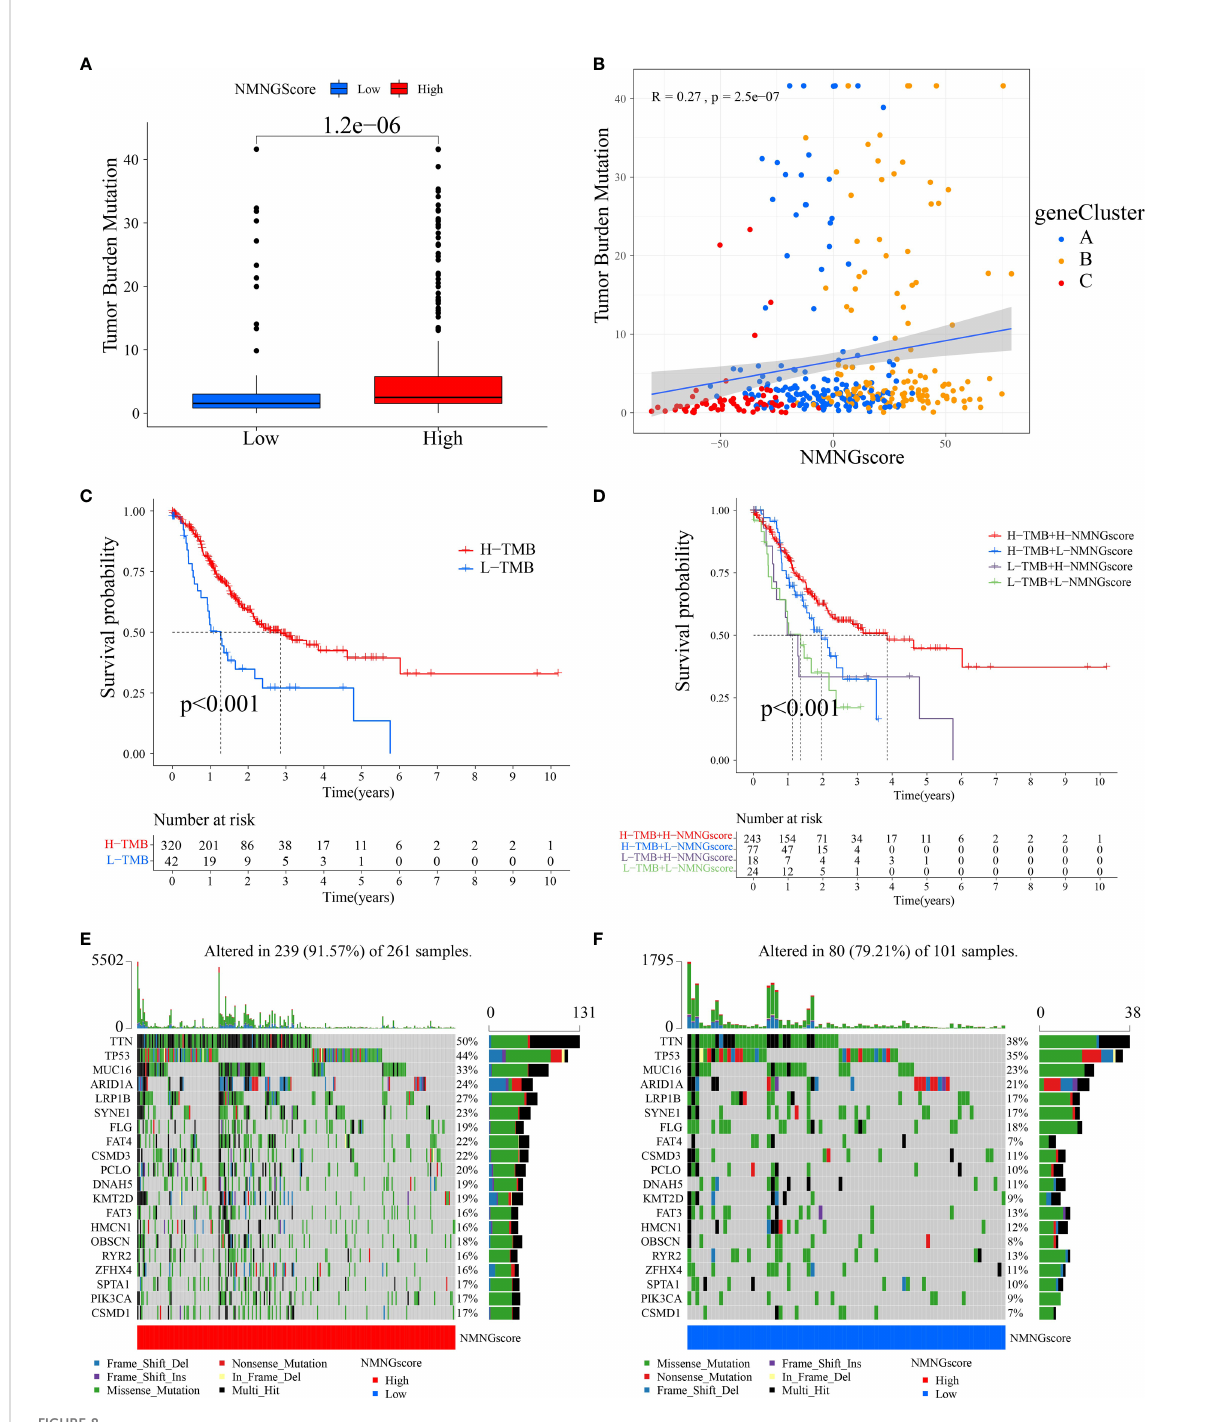
FIGURE 8 Features of NMNG modi fi cation in TCGA molecular subgroups and cancer somatic mutation. (A) The distribution differences of the tumor mutational burden (TMB) between low- and high NMNG-score categories in the TCGA-STAD cohort. (B) The correlation between NMNG score and TMB. (C) Survival assay for low and high TMB groups using KM curves. (D) Survival analyses for patients classi fi ed by NMNG score and TMB using KM curves. (E, F) Waterfall plot of cancer somatic mutations constructed from patients with (E) high NMNG score and (F) low NMNG